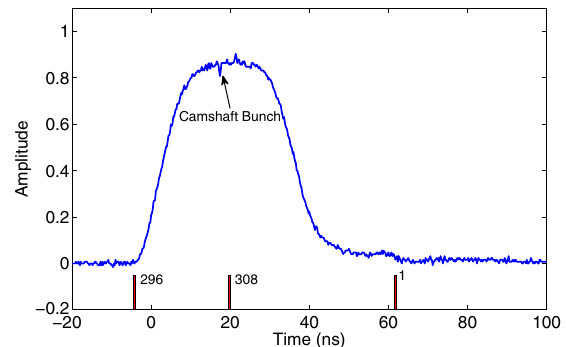
FIG. 7. Measured kicker pulse and camshaft bunch signals. The position of buckets 296, 308 and 1 are labeled in the plot. The camshaft bunch is filled at bucket